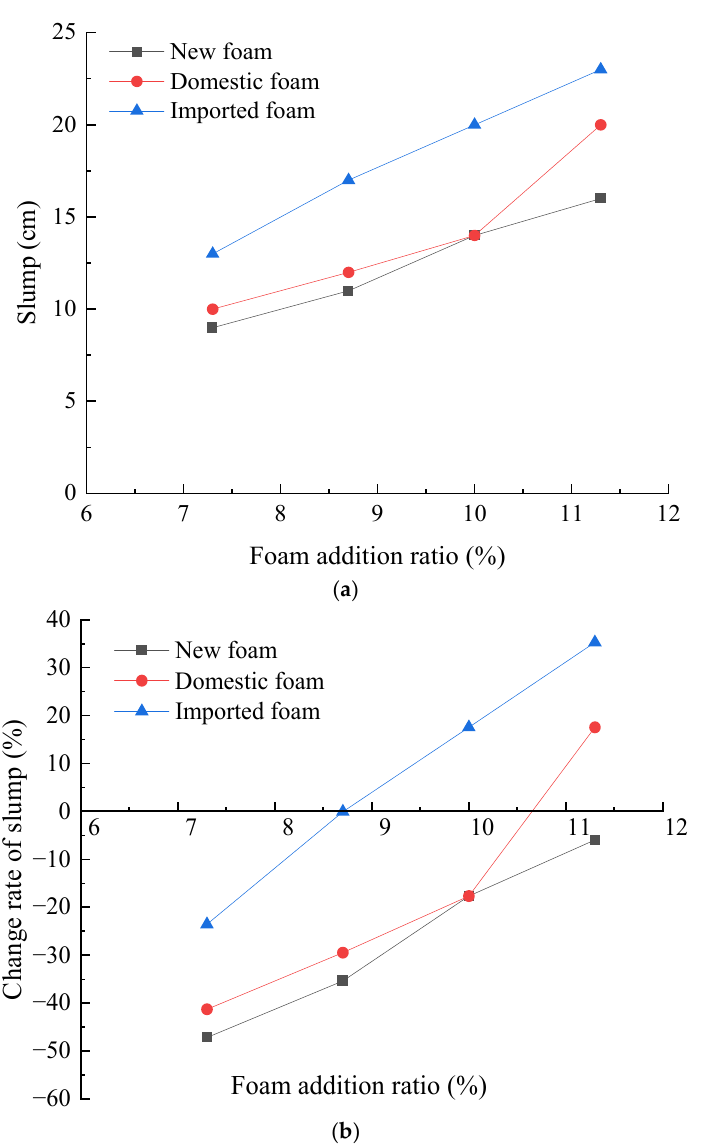
Figure 15. Comparison of slumping degree and slumping rate of change of sand soil with different foam agent modifications. ( a ) Slump change curve. ( b ) Change curve of slump change rate. The slumping degree of the soil is the control parameter of the whole test. When the slumping degree of the soil reaches more than 15 cm, it is considered that the fluidity of the soil meets the requirement of an ideal plastic flow state. Based on the curve in the figure, it can be seen that as the amount of foam added increases, the subsidence of sand can be significantly increased, and the fluidity of soil is increased. When the amount of foam is added to the three types of foam, the collapse value of the soil decreased by a certain amount compared to the pre-improvement, but when the foam continues to be added, the collapse value increases significantly. Overall, the collapse value increases with the amount of foam added. According to the change rate curve, the effect of improved sand and soil collapse of imported foam is better than that of the new foam and imported foam. At 10% foam addition, the value of soil collapse after imported foam improvement is 20 cm and the rate of change is 17.6%. The value of soil collapse after new foam improvement is 14 cm and the rate of change is − 17.6%. The value of soil collapse is 14 cm, and the rate of change is −